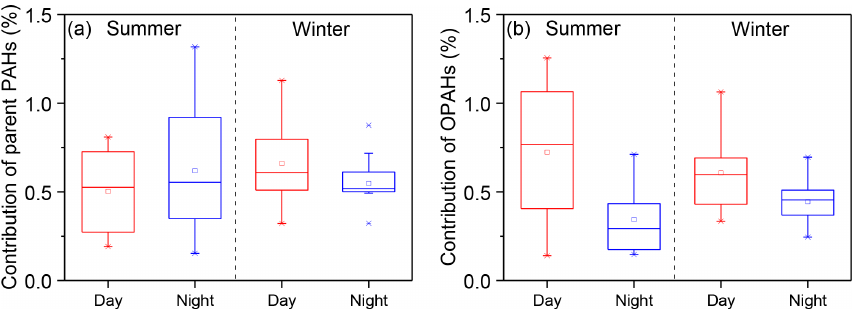
Figure 5. Average contribution of parent PAHs and OPAHs to the bulk light absorption of WI-BrC (300–700nm) during daytime and nighttime of summer and winter. Table 3. Average direct solar absorption of water-soluble and water-insoluble BrC during summer and winter. WSOC